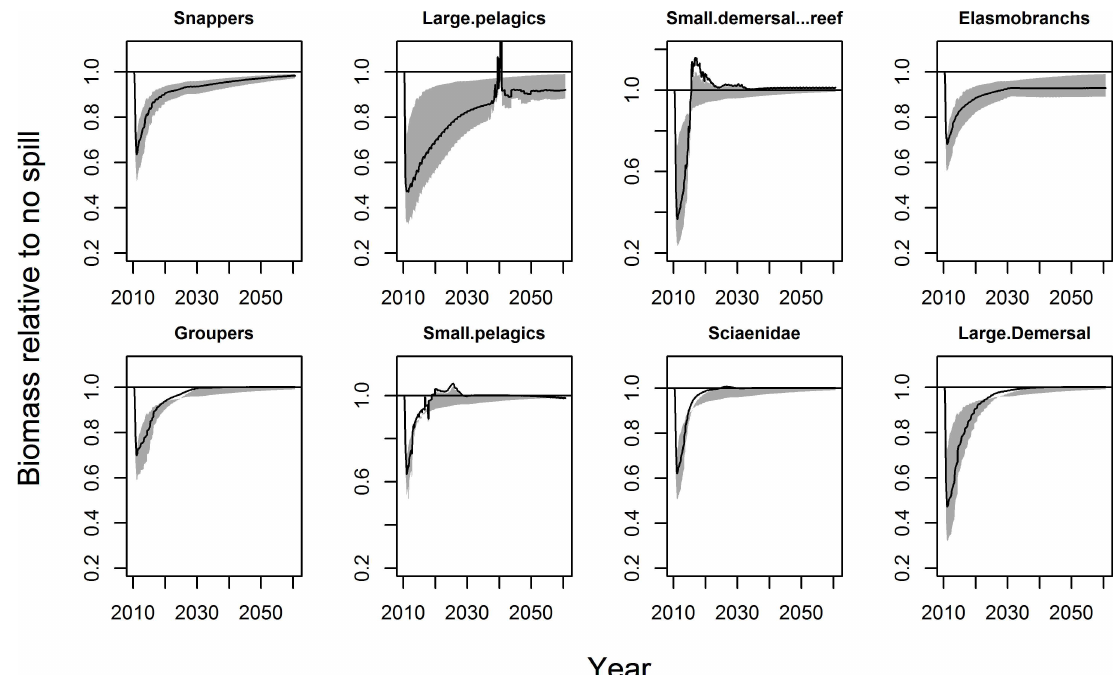
Fig 2. Biomass trajectories for species guilds. Biomasses are summed across all functional groups within these guilds. Shaded area shows range of outcomes observed in sensitivity analysis on concentration factor K and threshold β . Black line shows the mean of the 16 sensitivity